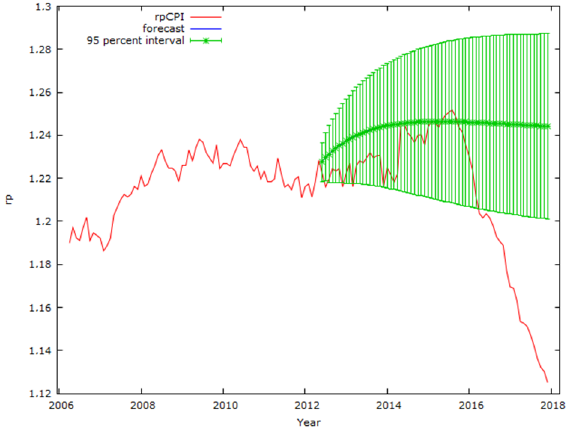
Figure A2. Time series forecasting for rp, the in-sample January 2000–May 2012, and the out-of-